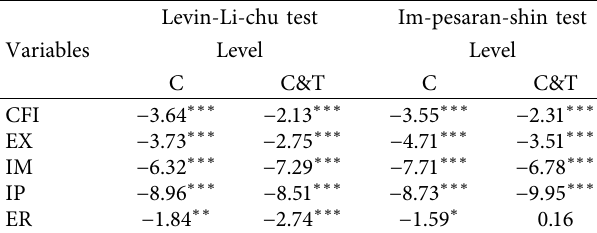
Table 4: Estimation results for the panel VAR models.